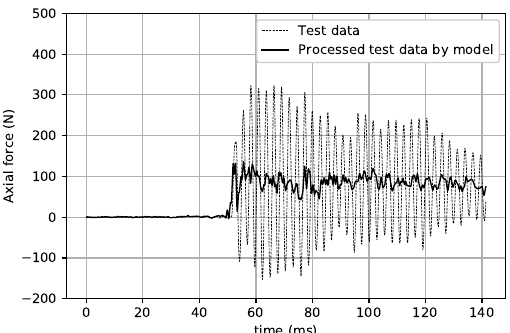
Figure 13. Test data and their processing by the model (axial